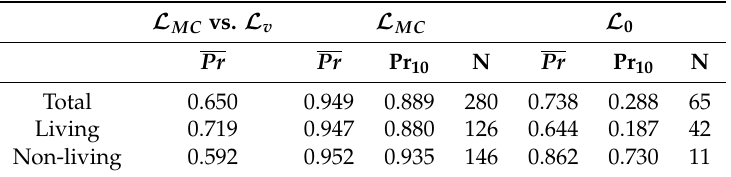
Table 3. Comparison of precision. The columns show the macro precision of MorphoCluster according to the original labels ( L MC vs L v ) and the macro precision of L MC and L 0 according to manual examination. Pr is the macro precision, Pr 10 the 10% quantile of individual precisions, and N the number of classes. The results are further broken down by living (animals, plants) and non-living (fibers, aggregates, feces, etc.)